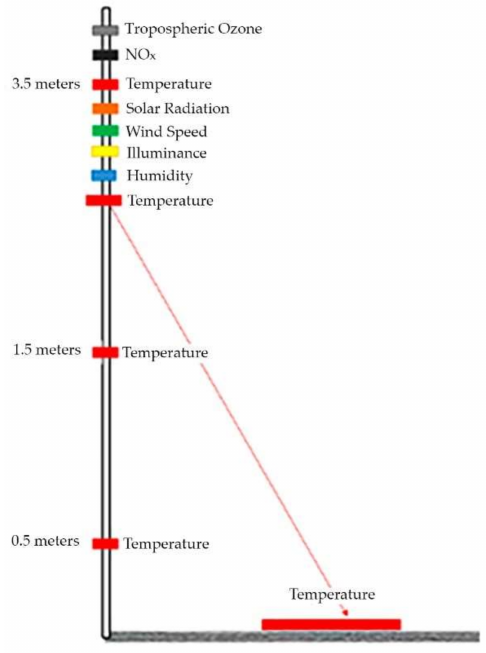
Figure 2. Detail of measuring